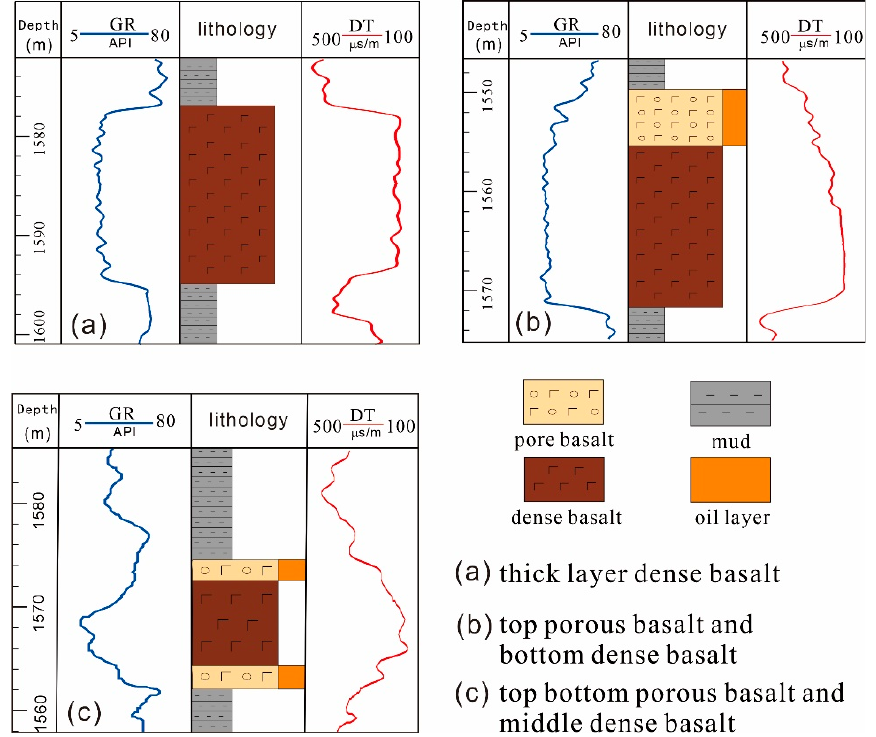
Figure 12. Log interpretation diagram of the lava unit in the fault block Zao35.